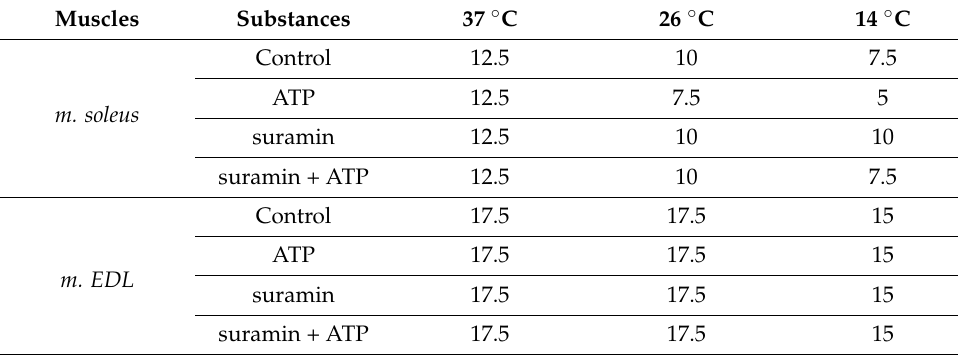
Table 2 . Effect of temperature on the fusion frequency of tetanic muscle contractions (in Hz) in control and with application of ATP and suramin at a concentration of 100 µM. n = 12.